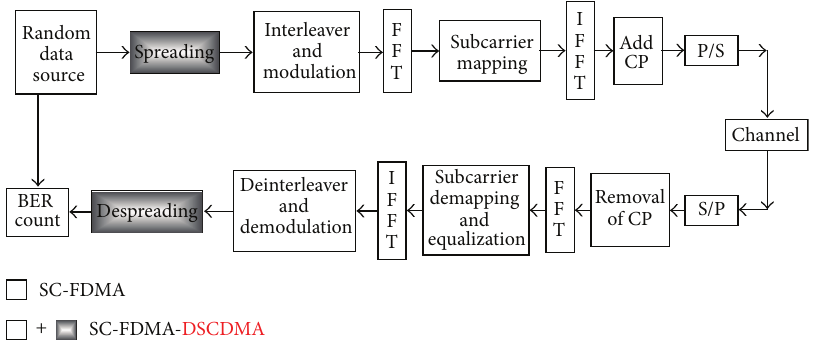
Figure 1: Modified SC-FDMA-DSCDMA system model. CDMA spreading operation has been performed before interleaving and